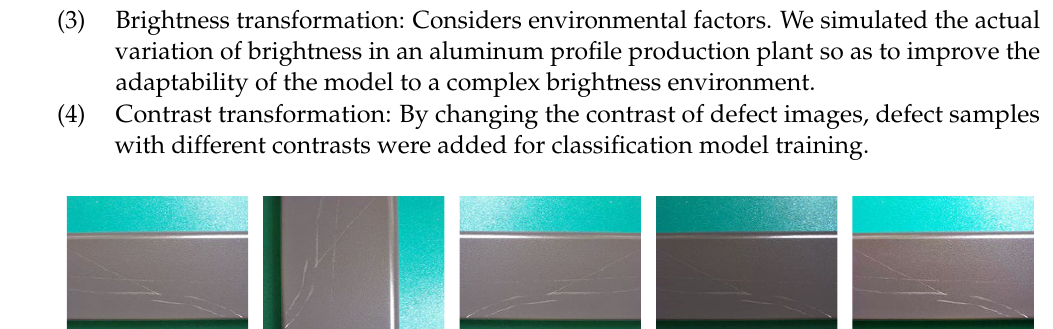
Table 2. The number of defect images in the augmented